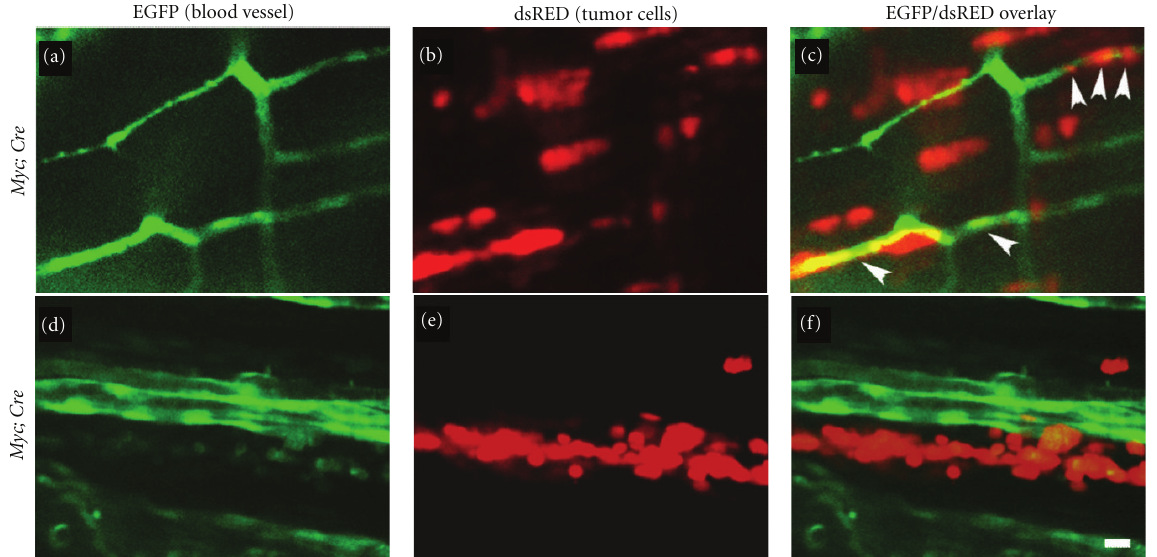
Figure 2: Zebrafish T-lymphoblasts overexpressing bcl2 spread locally but fail to intravasate into vasculature. (a)–(c) dsRED2-expressing lymphoma cells (b) from the Myc; Cre fish intravasate into EGFP-labeled vasculature (a) of the transplant host Tg(fli1:EGFP); Casper by 6 days posttransplantation (see arrowheads in (c)). (d)–(f) In contrast, dsRED2-expressing lymphoma cells (e) from the Myc; Cre; bcl2 fish fail to intravasate vasculature (d) of the transplant hosts by 6 days posttransplantation (compare (f) with (c)). Note aggregates of the Myc; Cre; bcl2 lymphoma cells in (e) and (f). Scale bar is 10 µ m. Reprinted from [10].